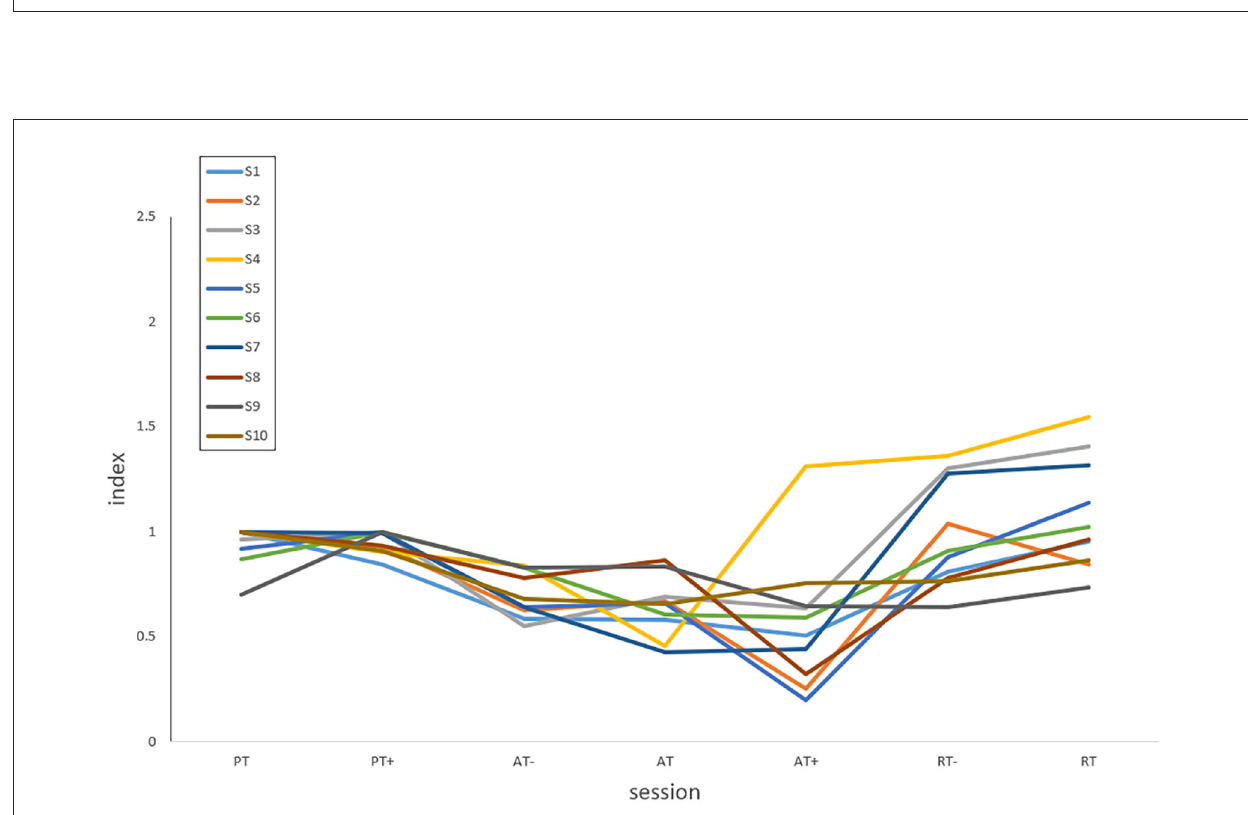
FIGURE16 The index of assistance level of 10 participants in seven experimental